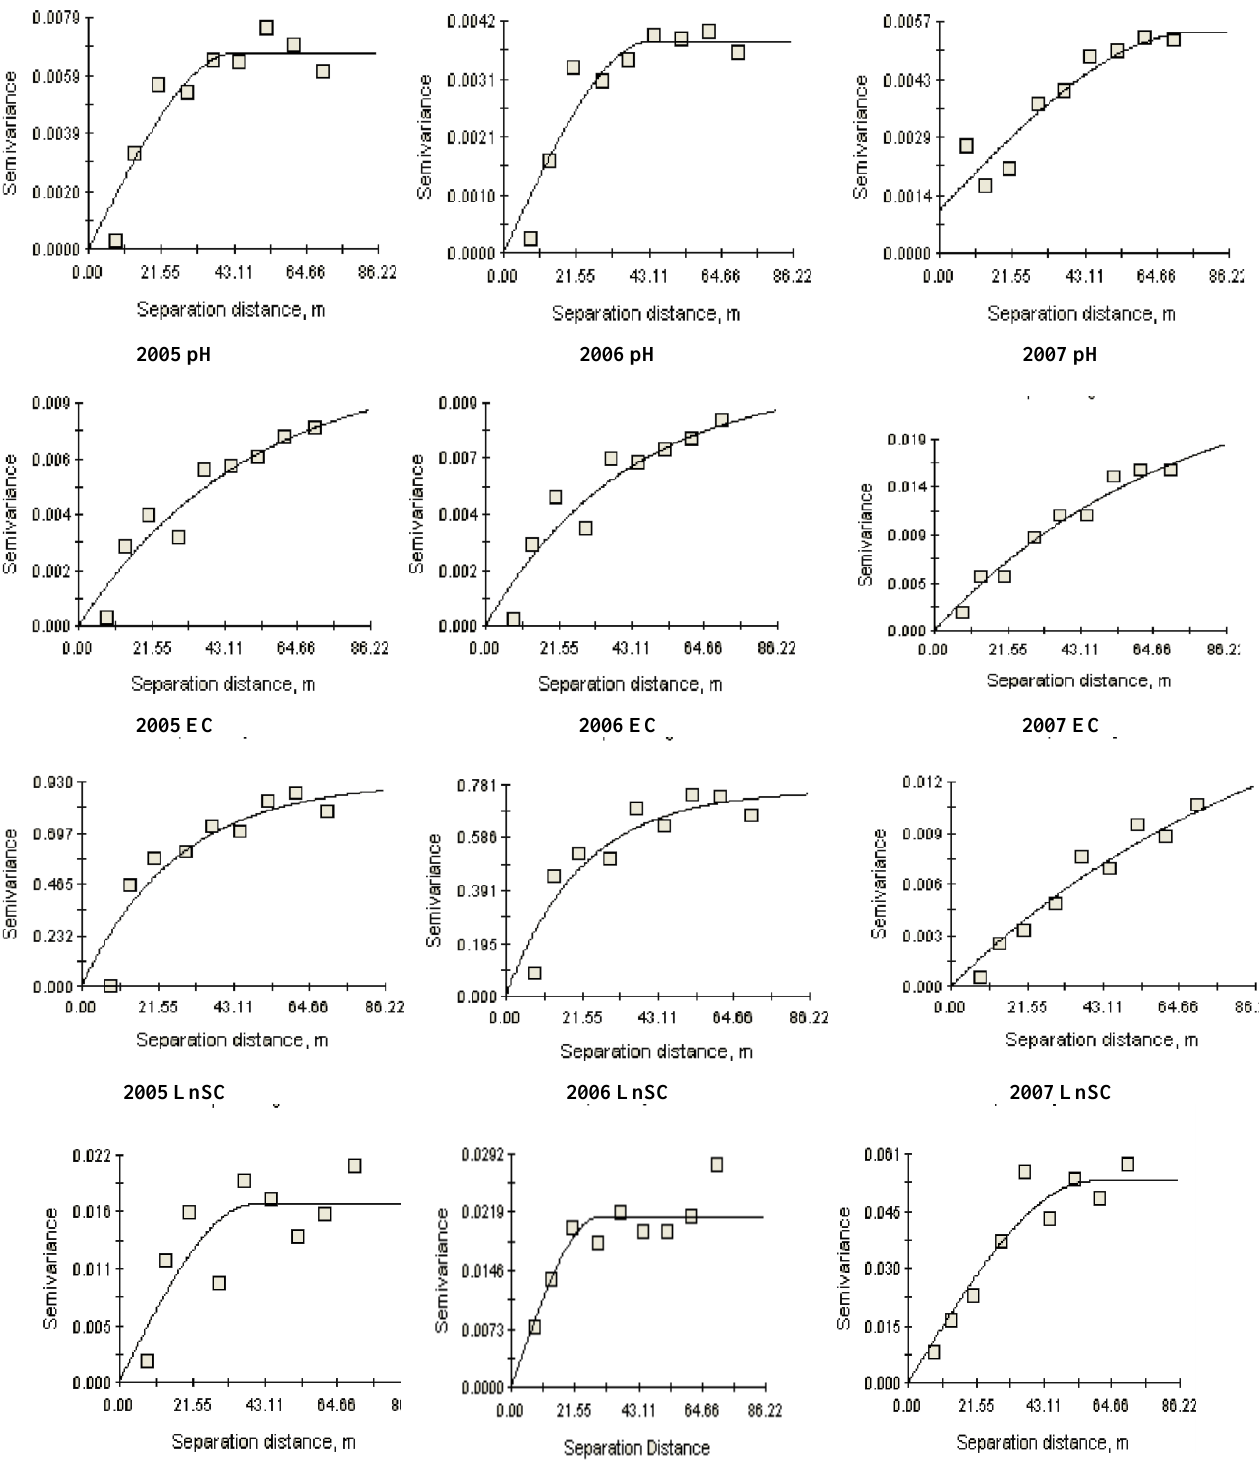
Figure 2. Best-fit semivariograms of soil salinization parameters from 2005 to 2007 year. SC is soil salinity content (mg·kg −1 ); EC is electrical conductivity (μs·cm −1 ); and SAR is sodium adsorption